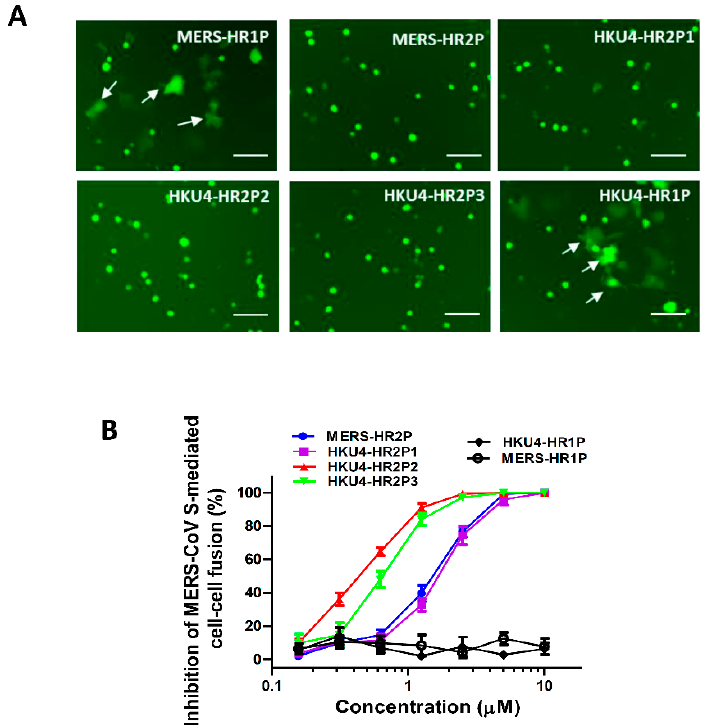
Figure 4. Inhibitory activity of peptides as demonstrated by MERS-CoV S-mediated cell–cell fusion assay. ( A ) Images of MERS-CoV S protein-mediated cell–cell fusion in the presence of MERS-HR1P, MERS-HR2P, HKU4-HR2P1, HKU4-HR2P2, HKU4-HR2P3 and HKU4-HR1P, respectively, all at the concentration of 10 µ M. Arrows show the fused cells. Scale bars, 800 µ m. ( B ) Inhibitory activities of MERS-HR2P, HKU4-HR2P1, HKU4-HR2P2, HKU4-HR2P3, HKU4-HR1P and MERS-HR1P against MERS-CoV S-mediated cell–cell fusion. Each sample was tested in triplicate and the data are expressed as means ± standard deviation (SD). Each experiment was repeated twice and similar results were obtained.